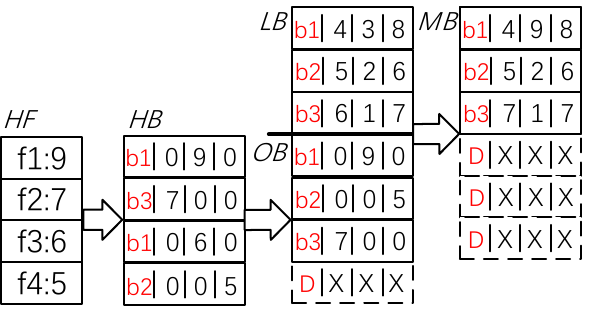
Figure 6. Obliv. max-merge of light part and heavy flows.